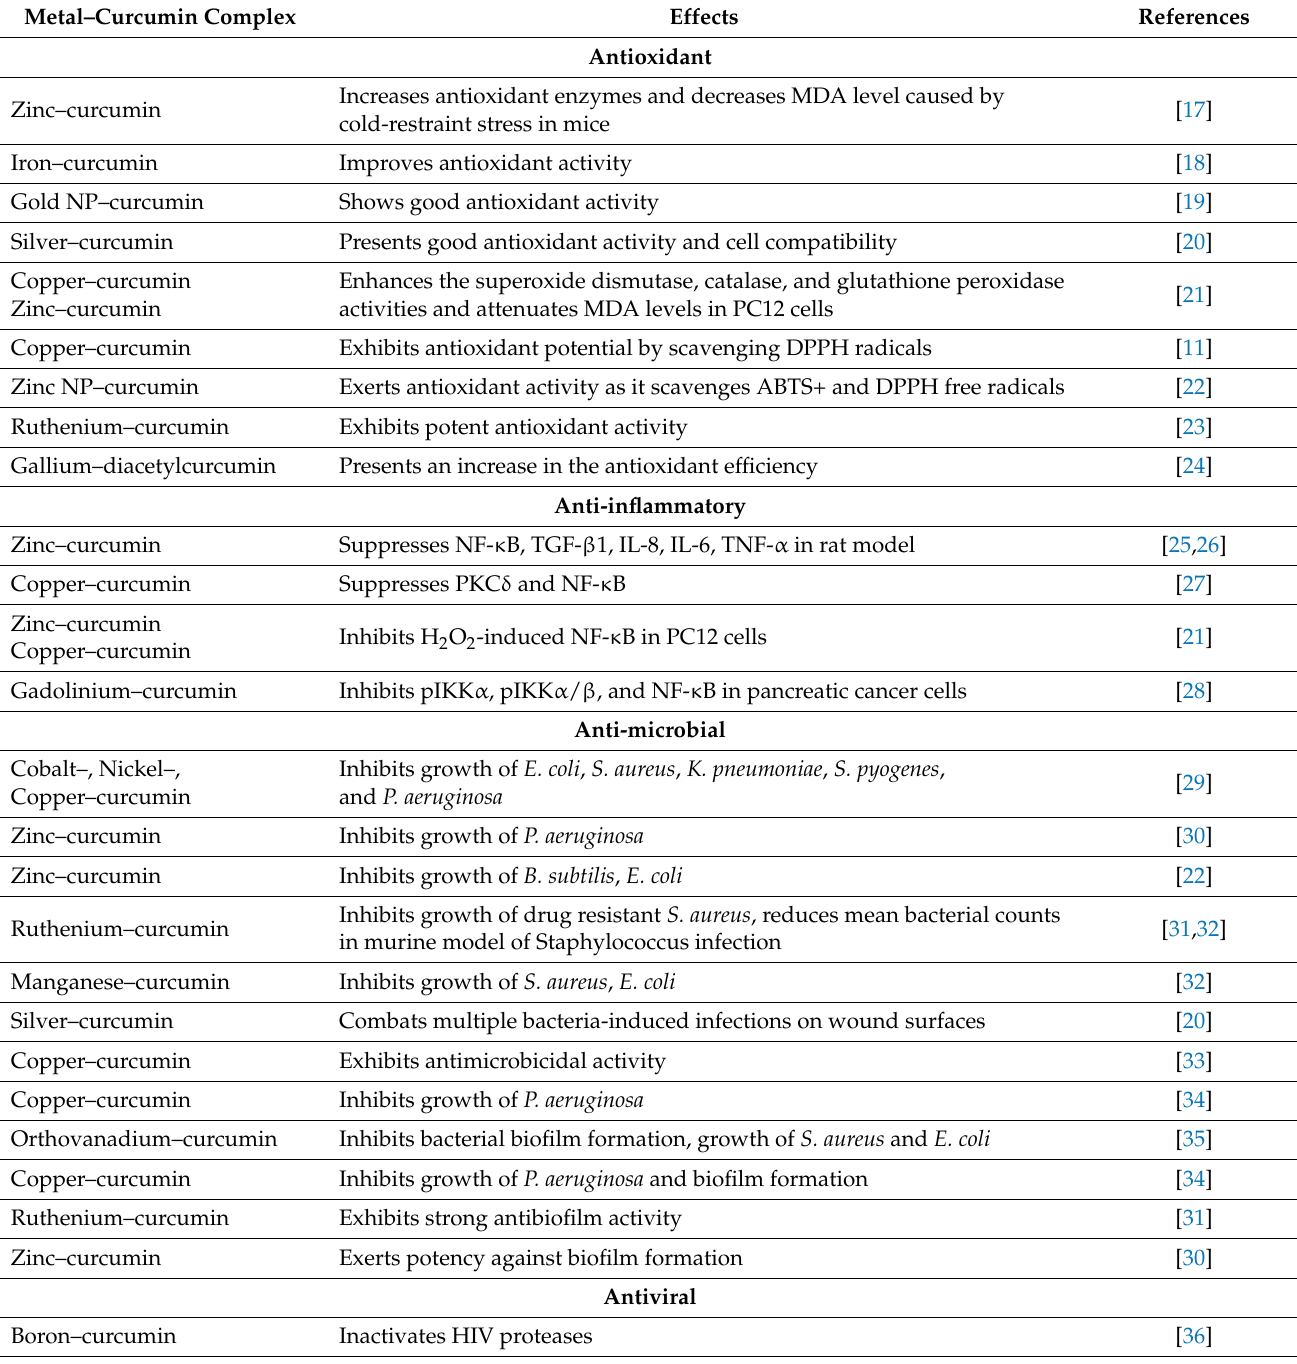
Table 1. Pharmacological effects of metal–curcumin